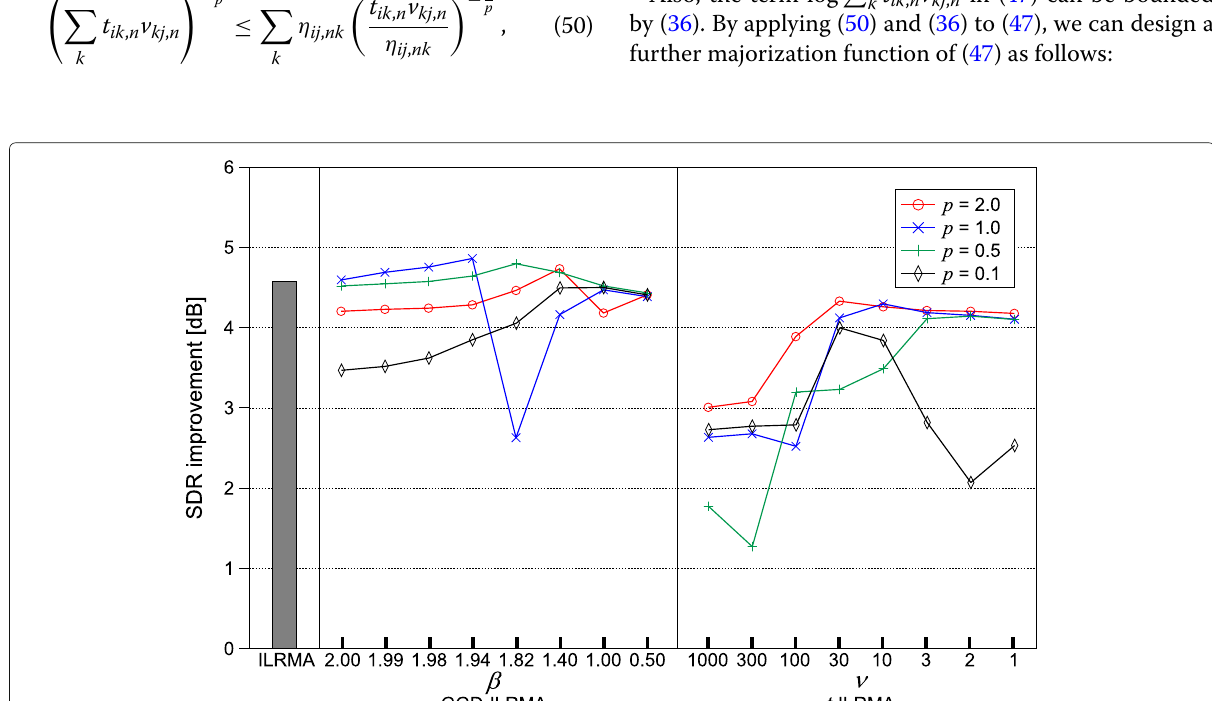
Fig. 23 Average SDR improvements of Speech 3 with E2A_2 signal using parameter